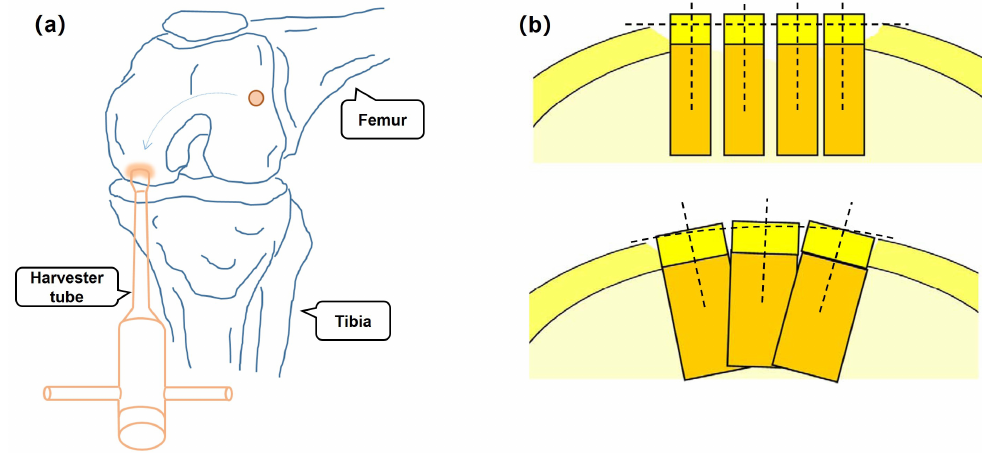
Figure 1. ( a ) Schematic representation of the OAT procedure. ( b ) Parallel graft insertion restores a flat surface, radial insertion can restore convexity